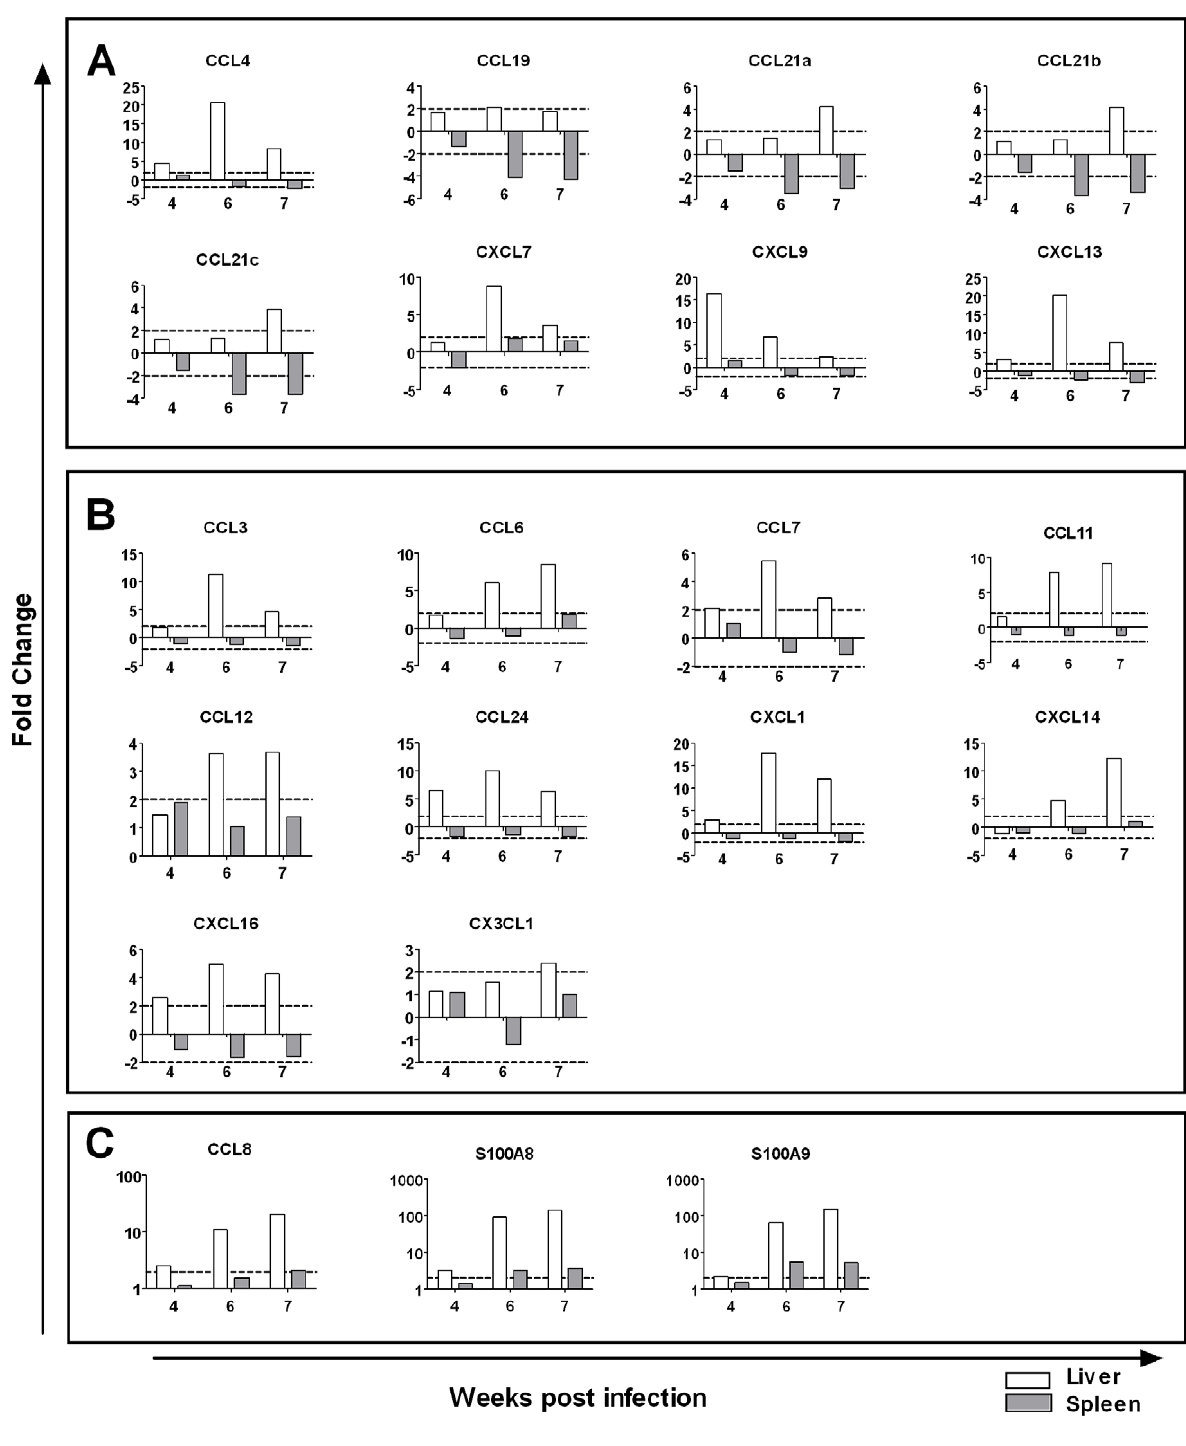
Figure 5. Contrasting expression of chemokines in the liver and spleen by microarray analysis. Comparison of spleen and liver transcriptional profiles identified a number of chemokines with contrasting expression. A: Chemokines up-regulated in the liver and down-regulated in the spleen during schistosome infection. B: Chemokines up-regulated in the liver and unchanged or below levels of detection in the spleen. C: Chemokines up-regulated in both organs showed greater expression in the liver. Graphs represent average fold change relative to uninfected tissue by microarray analysis. Dotted lines represent a 6 2 fold cut-off for biological significance. Expression values for the liver are derived from our previous study of the transcriptional profile of the S. japonicum infected liver [9].